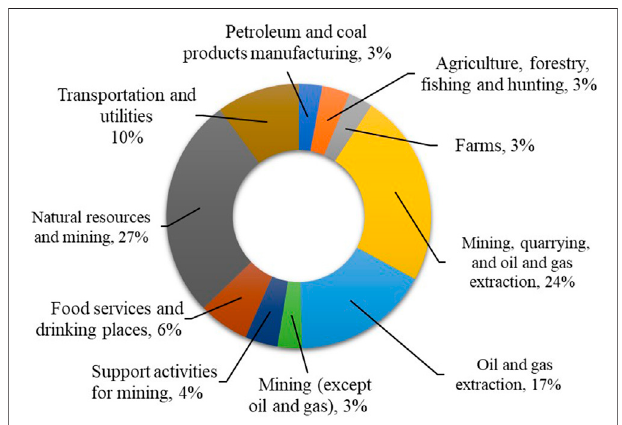
FIGURE 10 | Contributions of energy-related industries to New Mexico GDP in the year